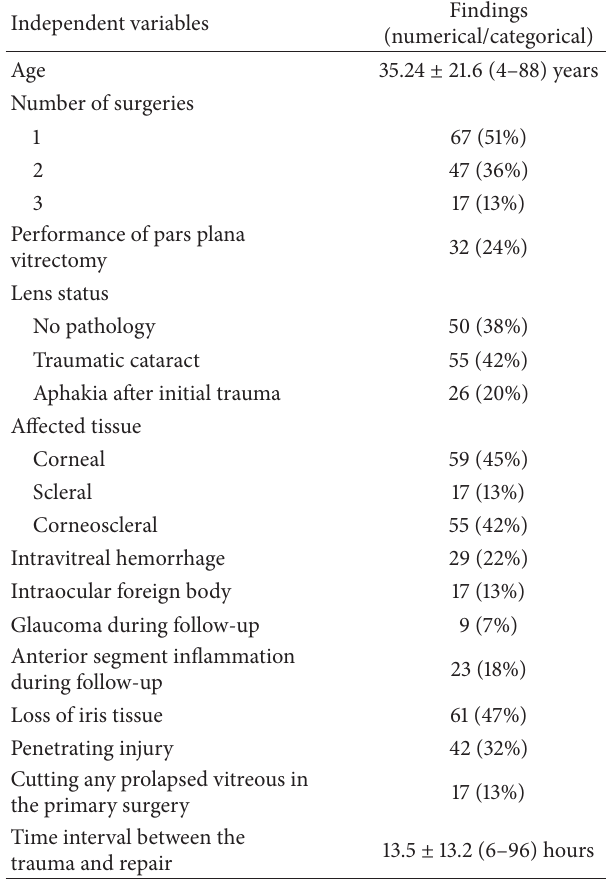
Table 1: The ocular trauma scores for one hundred thirty-one open glob injuries.